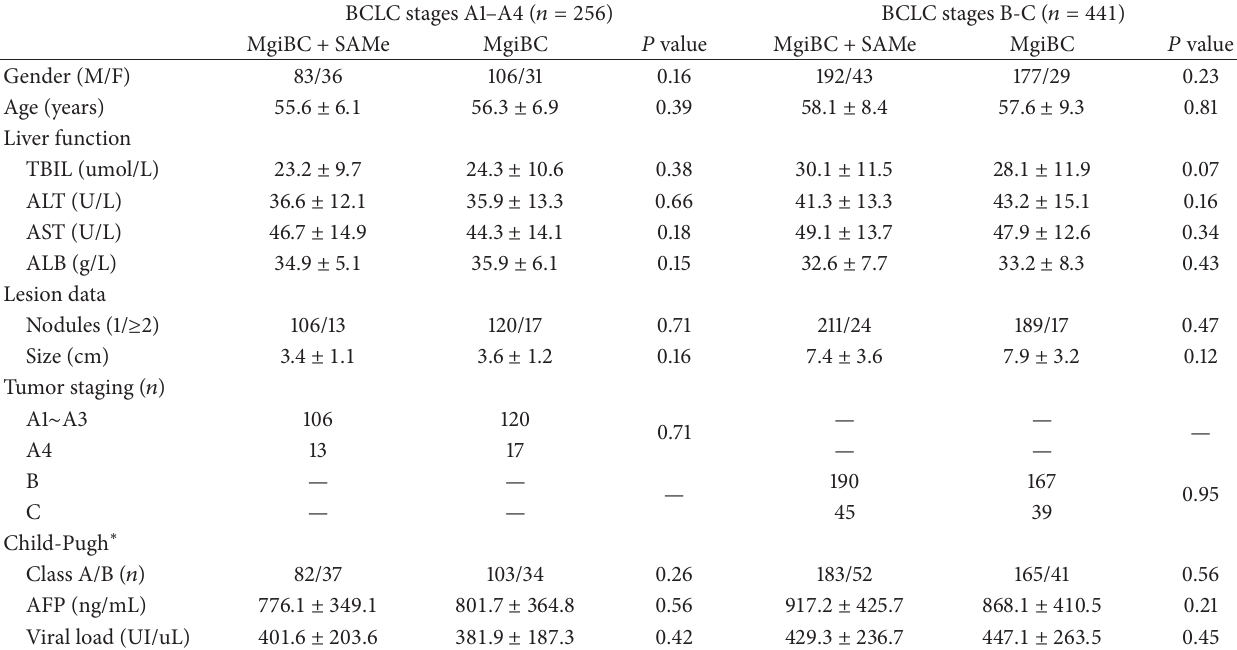
Table 1: General information for the included patients at